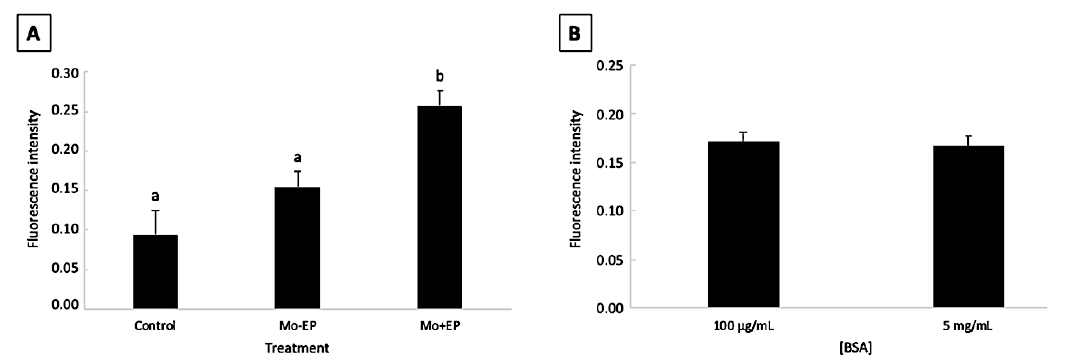
Figure 1. Main effect means of morpholino treatment ( A ) and bovine serum albumin concentration ( B ) on the fluorescence intensity of in vitro-produced blastocysts (mean standard error). Abbreviations: Mo, morpholino; BSA, bovine serum albumin; −EP, absence of endo-porter; +EP, presence of endo-porter. a, b Uncommon letters differ ( p <0.05).